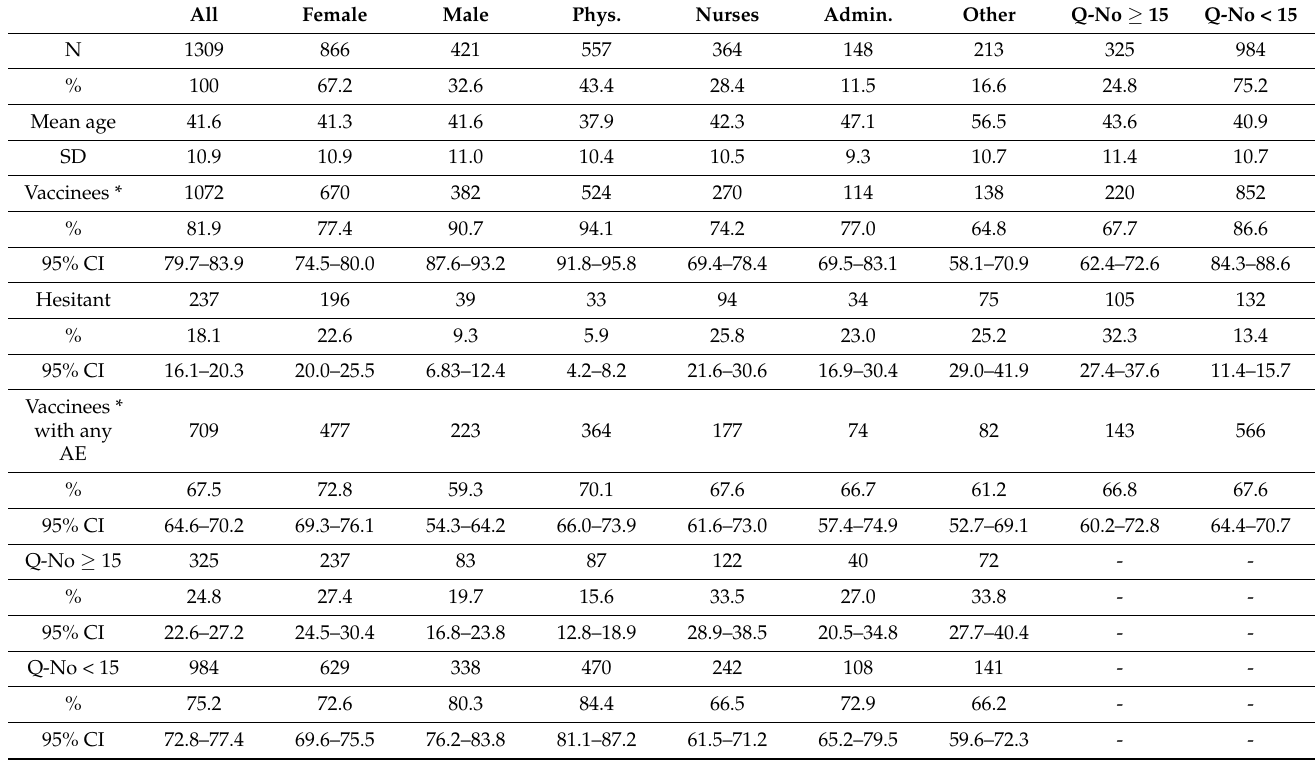
Legend: Percentages are based on the number of non-missing values. AE: adverse event; SD: standard deviation. P.: participants, Phys: physicians, Admin: administration staff; Other staff included physiotherapists, social workers, psychologists, and biologists. CI: confidence intervals. Participants with adverse events reporting at least one AE after complete vaccination (e.g., both doses of vaccines, or one dose with single-shot vaccine). (*) Vaccinees were considered participants with at least one dose of vaccine.